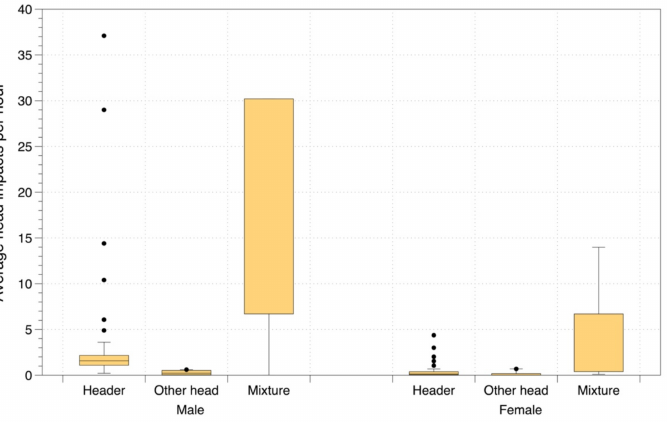
Figure 4. Number of head impacts per hour for male and female players, categorised by heading and mixed head